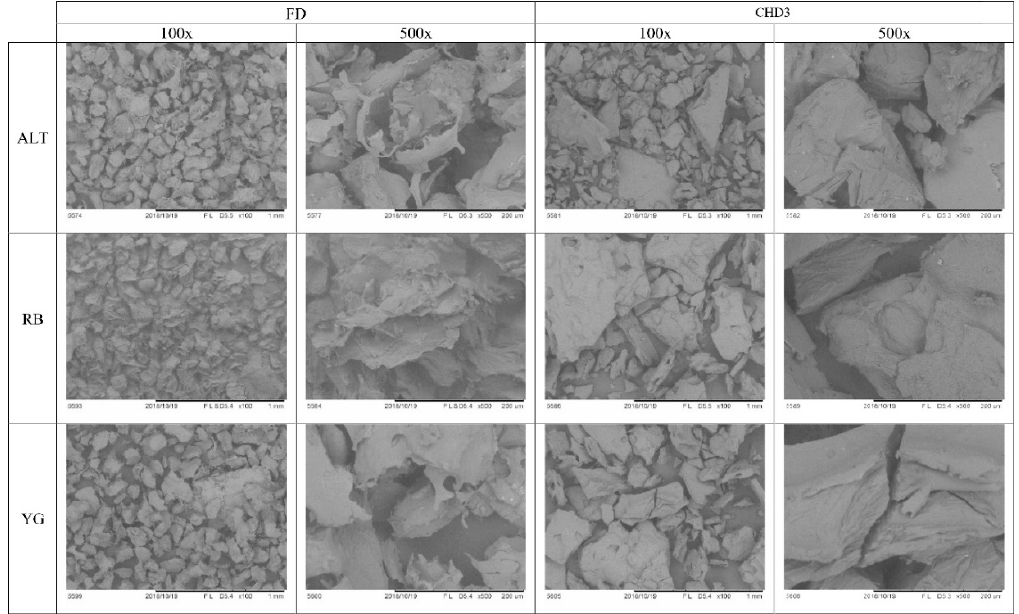
Figure 5. Scanning electron microscope (SM) images of three potato genotypes (rows) and two treatments (columns): freeze-dried (FD) and conductive hydro-drying (CHD3), at two magnifications (100× and 500×). For all cultivars, FD showed extensive cellular damage (columns 1 and 2), whereas CHD3 showed less granule damage although sheering can be observed (columns 3 and 4).